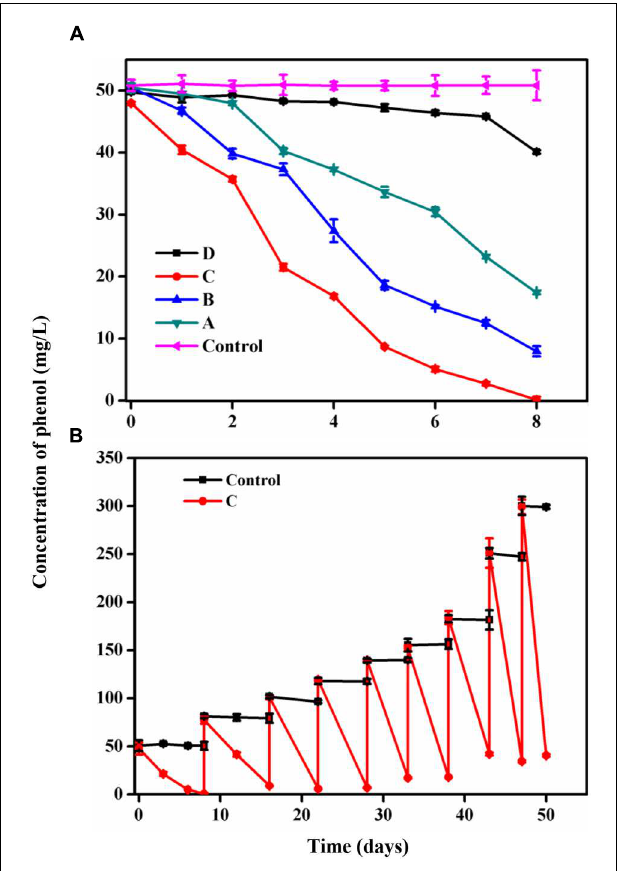
FIGURE 1 | (A) Phenol biodegradation in the four microcosms during 8-day acclimation. (B) the sample C were continuously acclimated with different concentrations of phenol in 50 days. No phenol degradation occurred in autoclaved control bottles. The mean values for three active bottles and three control bottles were